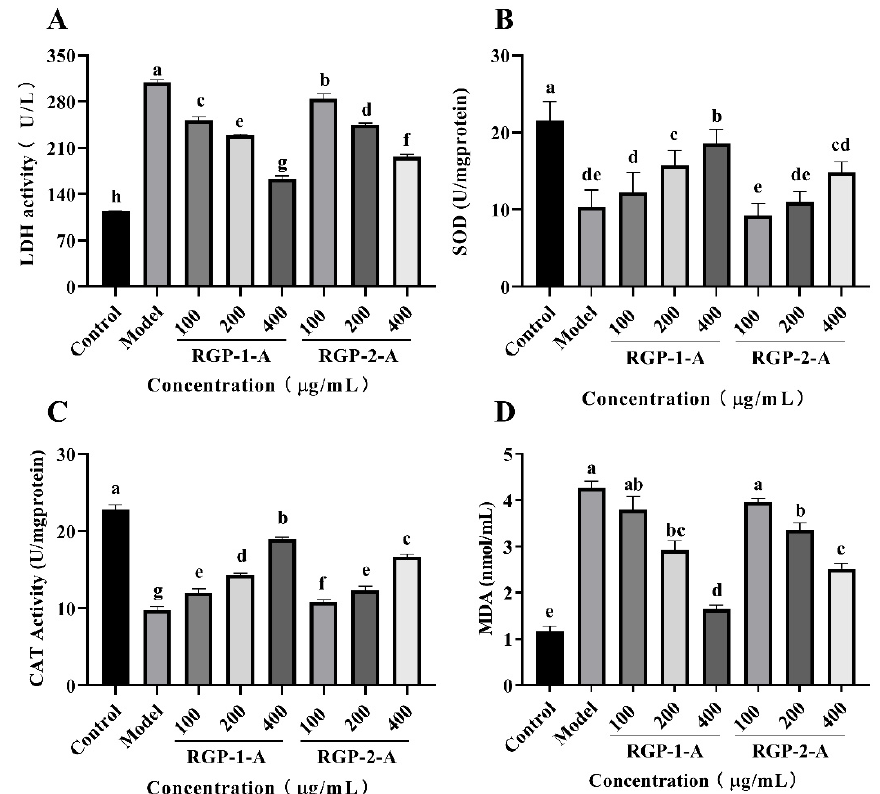
Figure 8. Effects of RGP − 1 − A and RGP − 2 − A on H 2 O 2 -induced IPEC-1 cell injury and intracellular antioxidant activity. Levels of LDH ( A ), SOD ( B ), CAT ( C ), and MDA ( D ) were measured using kits. RGP − 1 − A: Rehmannia glutinosa polysaccharides decolorized by the AB-8 macroporous resin; RGP − 2 − A: Rehmannia glutinosa polysaccharides decolorized by H 2 O 2 . Different lowercase letters on the bar graph indicate significant differences ( p < 0.05).